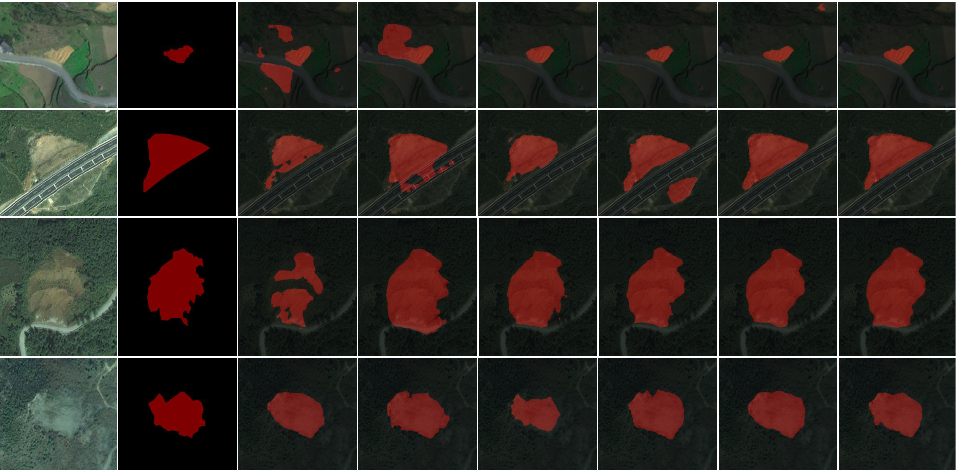
Figure 5. Model prediction of landslide results. Horizontally, they are Landslide I, Landslide II, Landslide III and Landslide IV. Vertically, they are the landslide image, label map (for comparison) , U-Net (VGG) recognition map, DeepLabv3+ (Xception) recognition map, DeepLab v3+ (MobileNet) recognition map, U-Net (ResNet50), the recognition map of PSPNet (MobileNet) and the recognition map of PSPNet